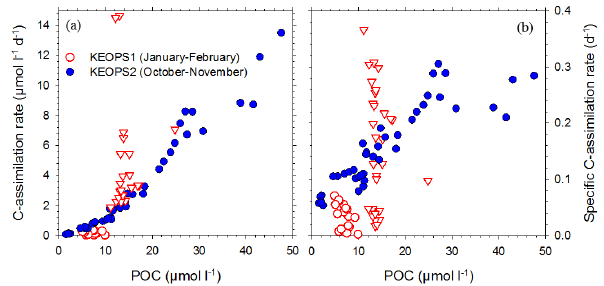
Figure 6. Relationship in the euphotic layer (100 to 1% PAR) be- tween biomass (POC) and net primary production (a) and specific C assimilation rates (growth rate) (b) . The KEOPS2 stations are rep- resented in blue, with the circles for the HNLC station (R-2), the normal triangles for the meander stations (E1 to E5), the inverse tri- angles for the plateau stations (A3-2 and E4-W), and the squares for the station north of the polar front (F-L). The KEOPS1 stations are in red (Raimbault, KEOPS 1 database). Inversed red triangles repre- sent the stations over the south-east Kerguelen Plateau, and the red circles represent the HNLC area east of the plateau (not sampled during